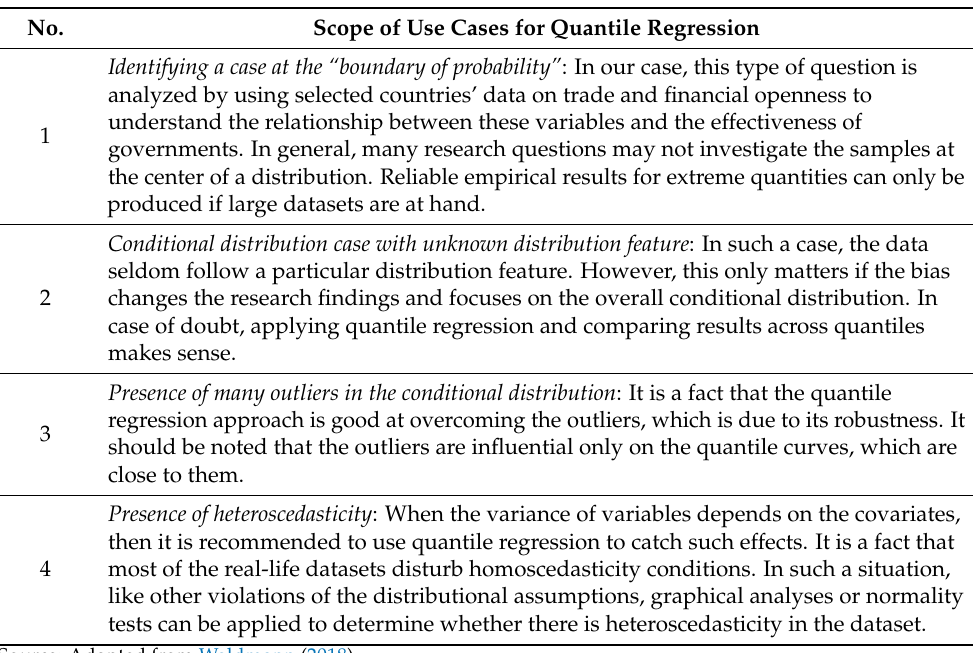
Table 3. Conditions suitable for using quantile regression.